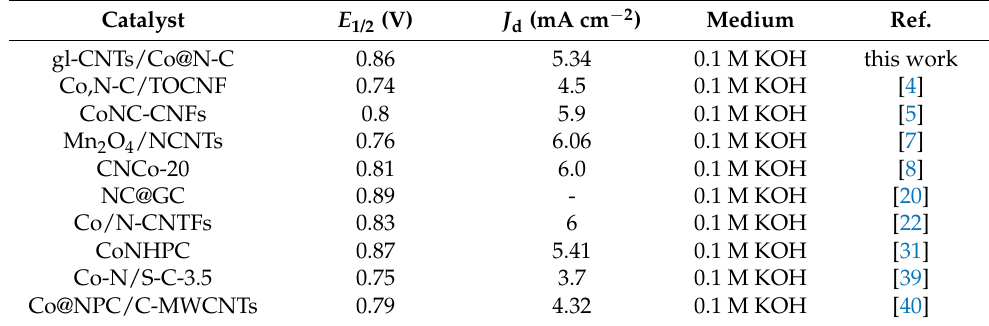
Table 2. Comparisons between gl-CNTs/Co@N-C and other catalysts over ORR. Catalyst